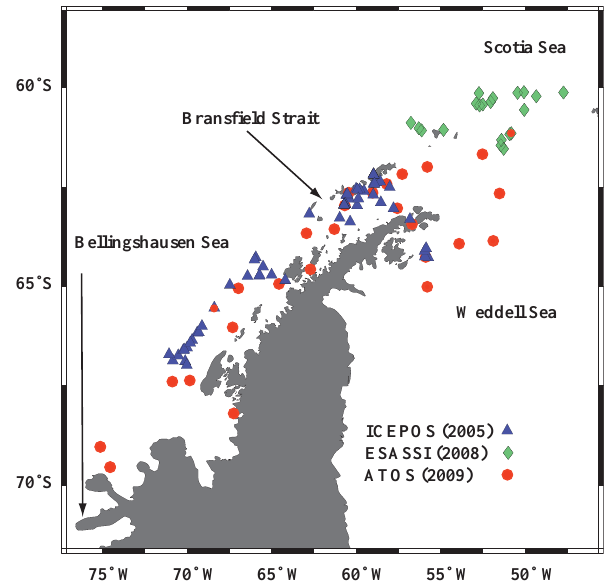
Figure 1. Map of the region and the stations sampled during the three cruises: ICEPOS 2005 (blue triangles), ESASSI 2008 (green diamonds) and ATOS-Antarctica 2009 (red